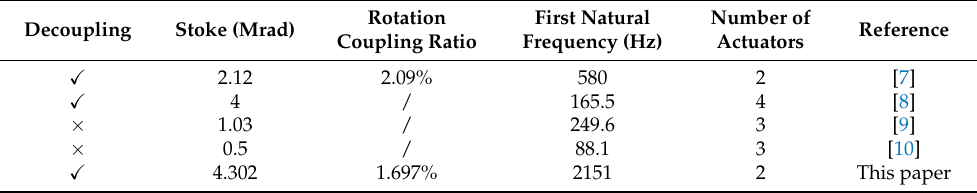
Table 5. Comparisons of performance results with other piezo-actuated rotation